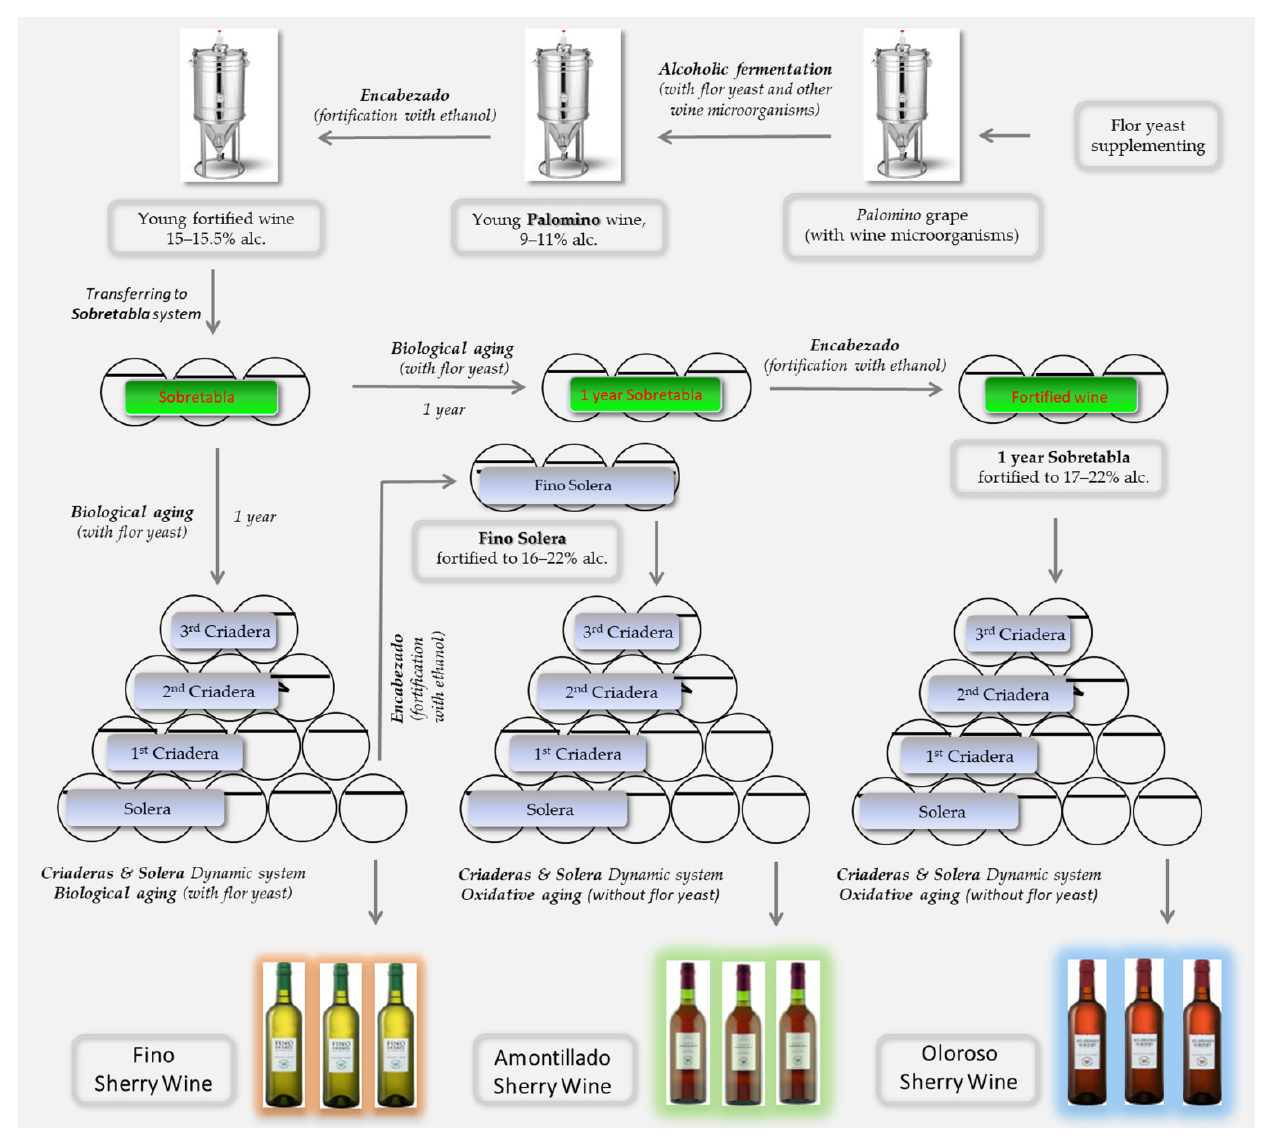
Figure 2. Manufacturing process for sherry wines: Fino, Amontillado, and Oloroso. Table 2. Major properties of dry sherry wines.